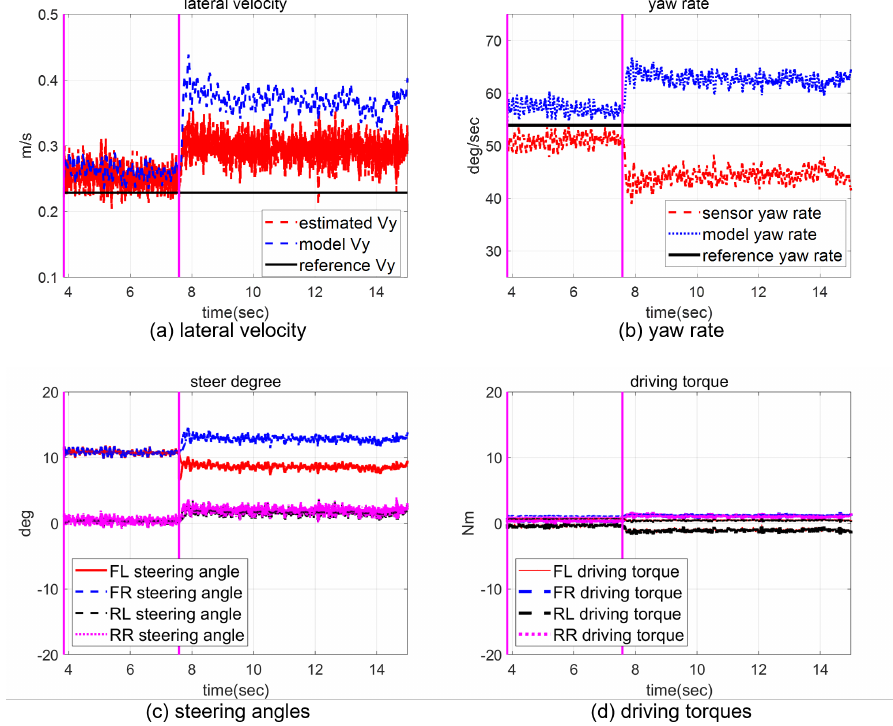
Figure 6. The closed-loop responses in the steady-state cornering maneuver. A fault occurs at 6.62